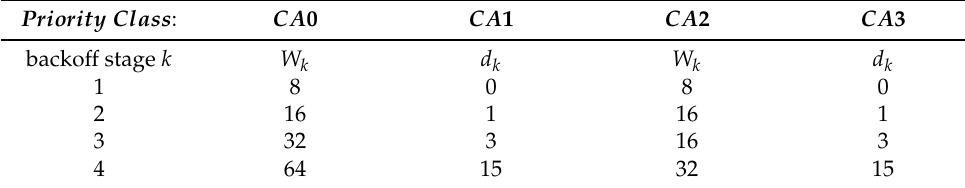
Table 1. The maximum backoff counter W k [16] and the value of d k [16] for 1901 protocol. Priority Class :